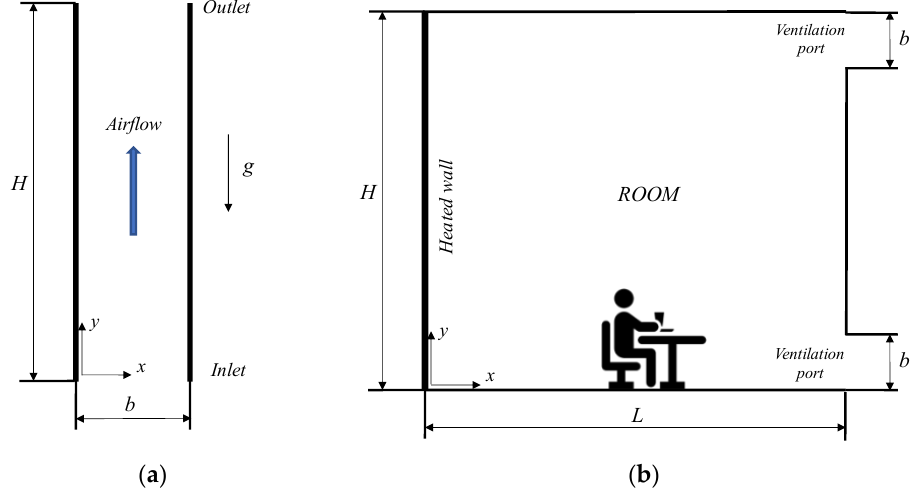
Figure 1. Basic configurations: ( a ) Simple vertical channel. Different symmetrical and asymmetrical heating conditions have been studied; ( b ) Typical arrangement of a cavity oriented to passive solar devices. Multiple combinations of heating conditions, and locations of apertures and ventilation ports have been analyzed in the literature.